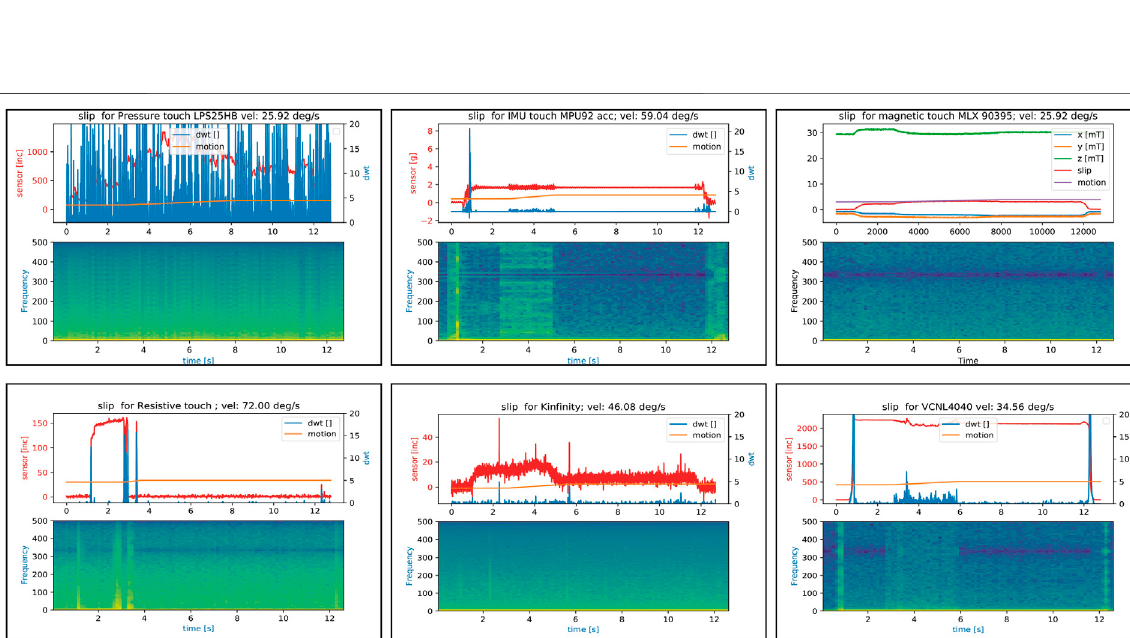
Frontiers in Robotics and AI |